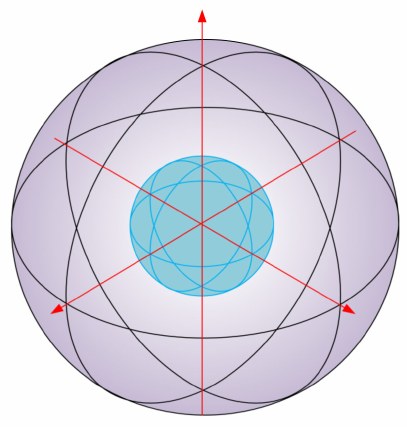
Figure 7. Signature structure for